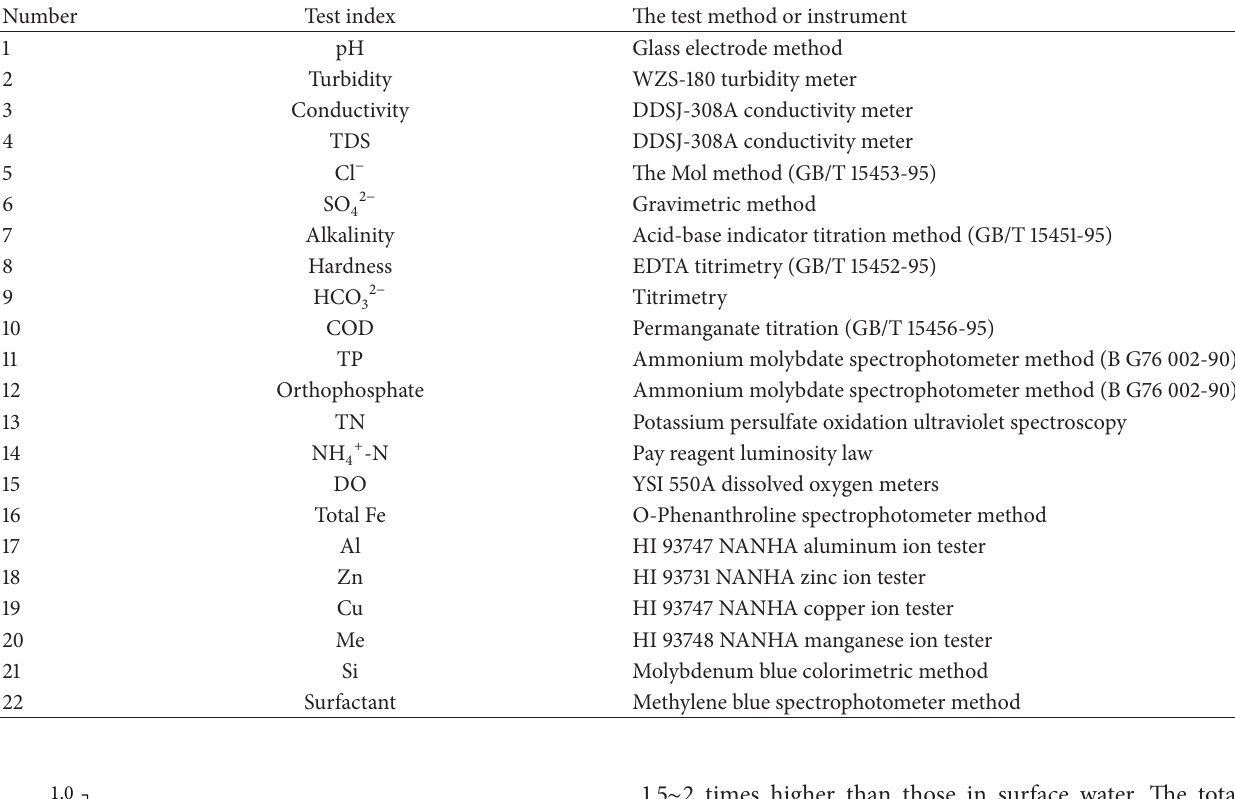
Table 1: Analytical methods of water quality.